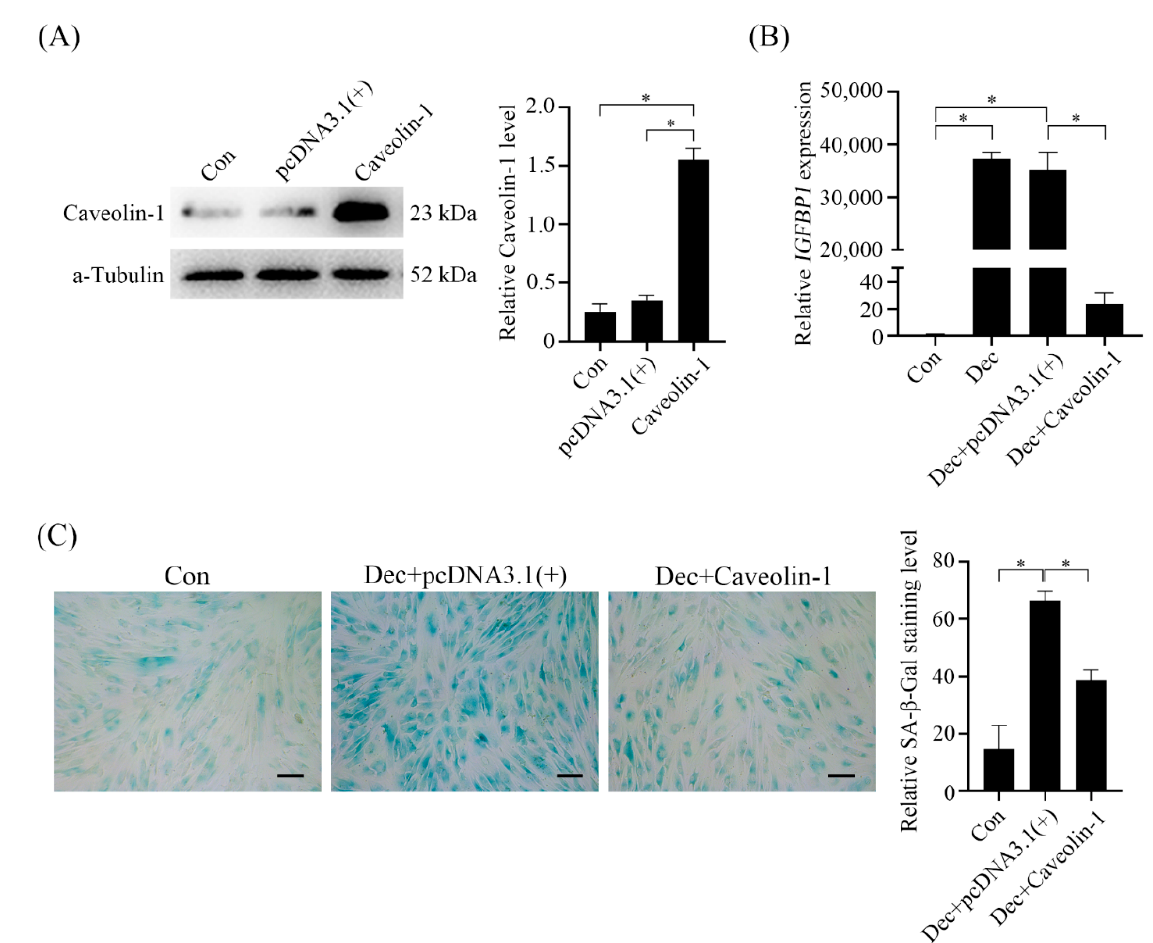
Figure 8. Effects of Caveolin-1 over-expression on human in vitro decidualization. ( A ) Western blot and semi-quantitative analysis of Caveolin-1 protein levels in Caveolin-1-overexpressed human stromal cells. ( B ) Real-time PCR analysis of IGFBP1 mRNA expression in Caveolin-1-overexpressed stromal cells under in vitro decidualization. ( C ) SA- β -Gal staining and semi-quantitative analysis in Caveolin-1-overexpressed stromal cells under in vitro decidualization for 6 days. Scale bar = 20 μ m. *, p < 0.05.